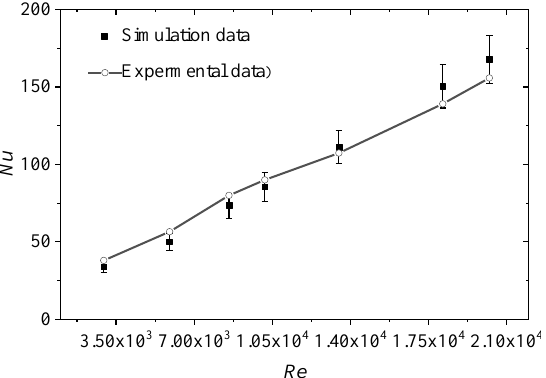
Figure 11. Validation of Nu for different Re .